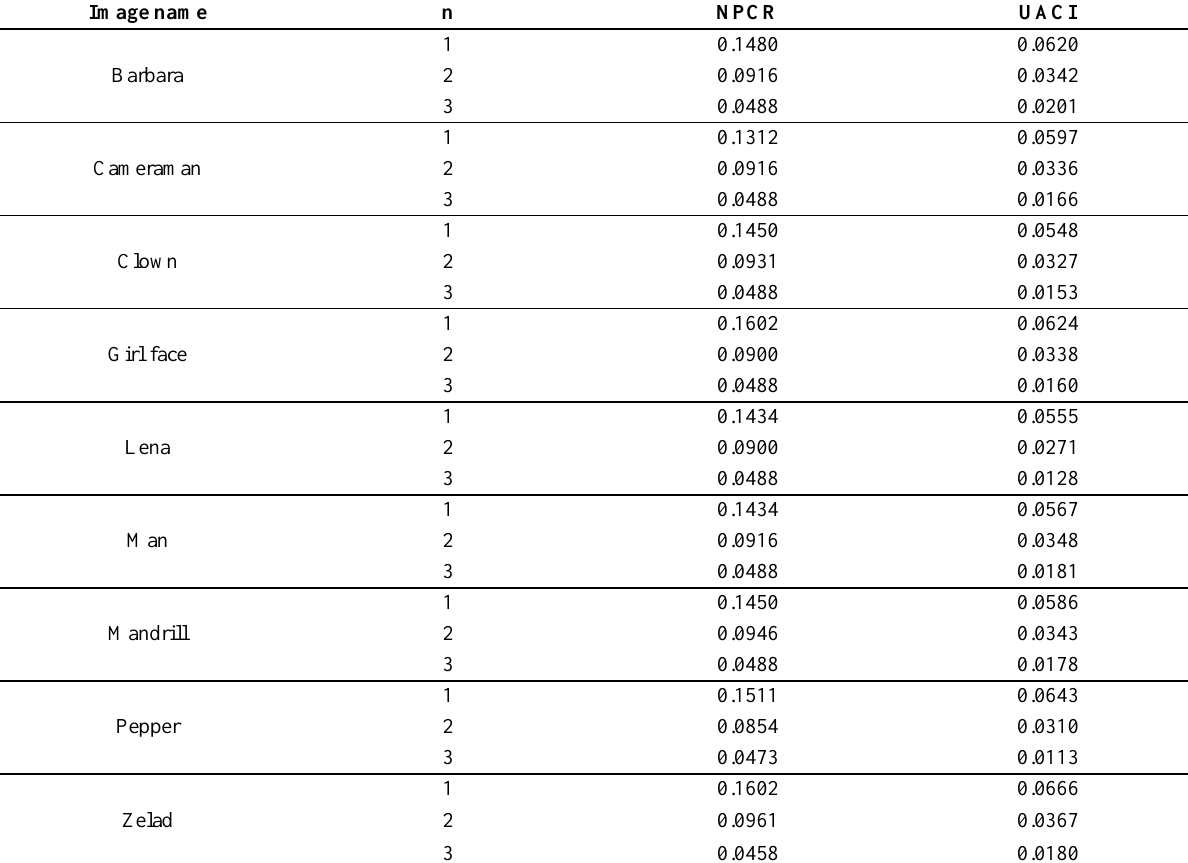
Table 6. NPCR and UACI analysis of the proposed method in all the case of N